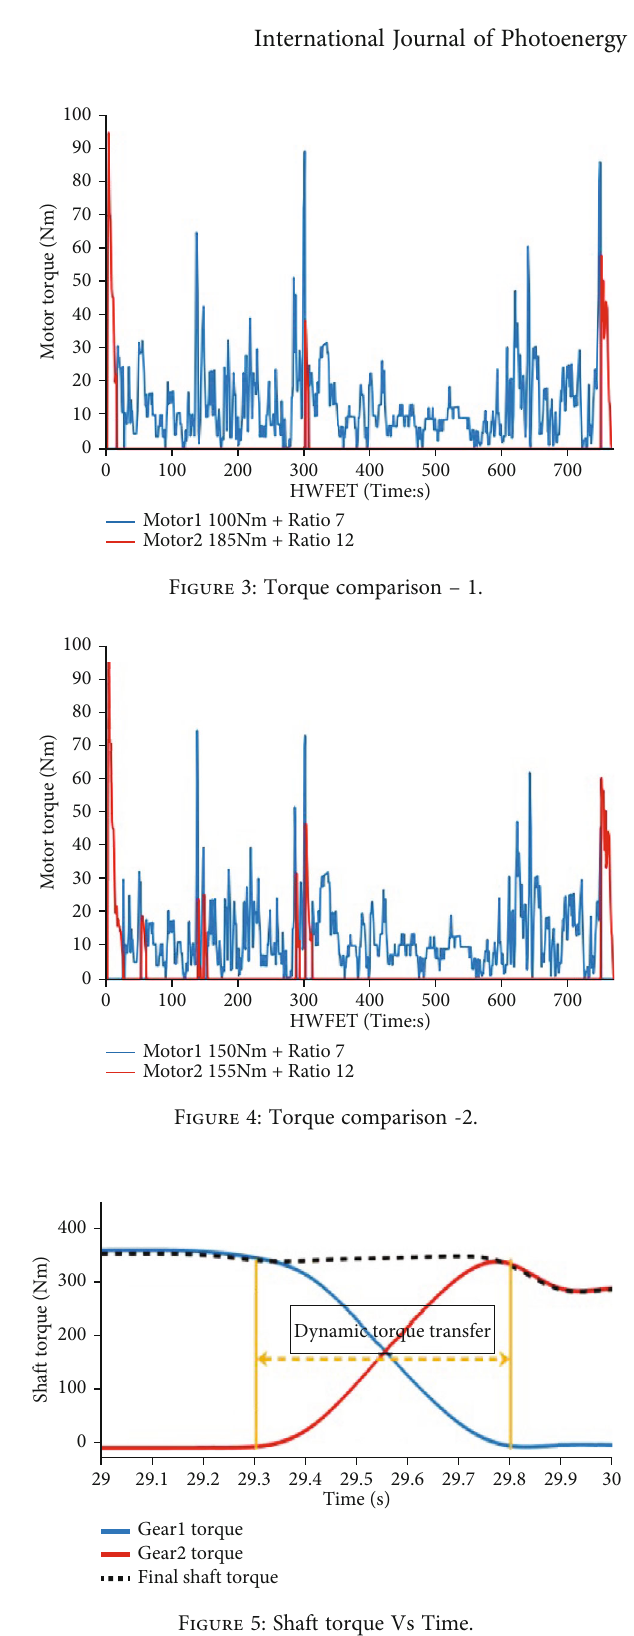
Figure 5: Shaft torque Vs